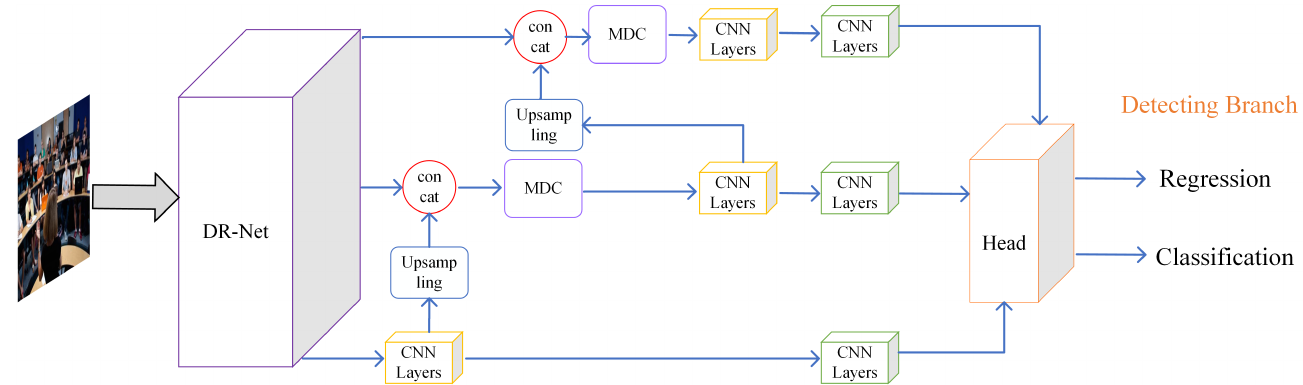
Figure 6. The complete network structure diagram. The features are first extracted by DR-Net, and then, the FRN is completed by a series of upsampling and fusion and then sent to MDC to obtain a larger receptive